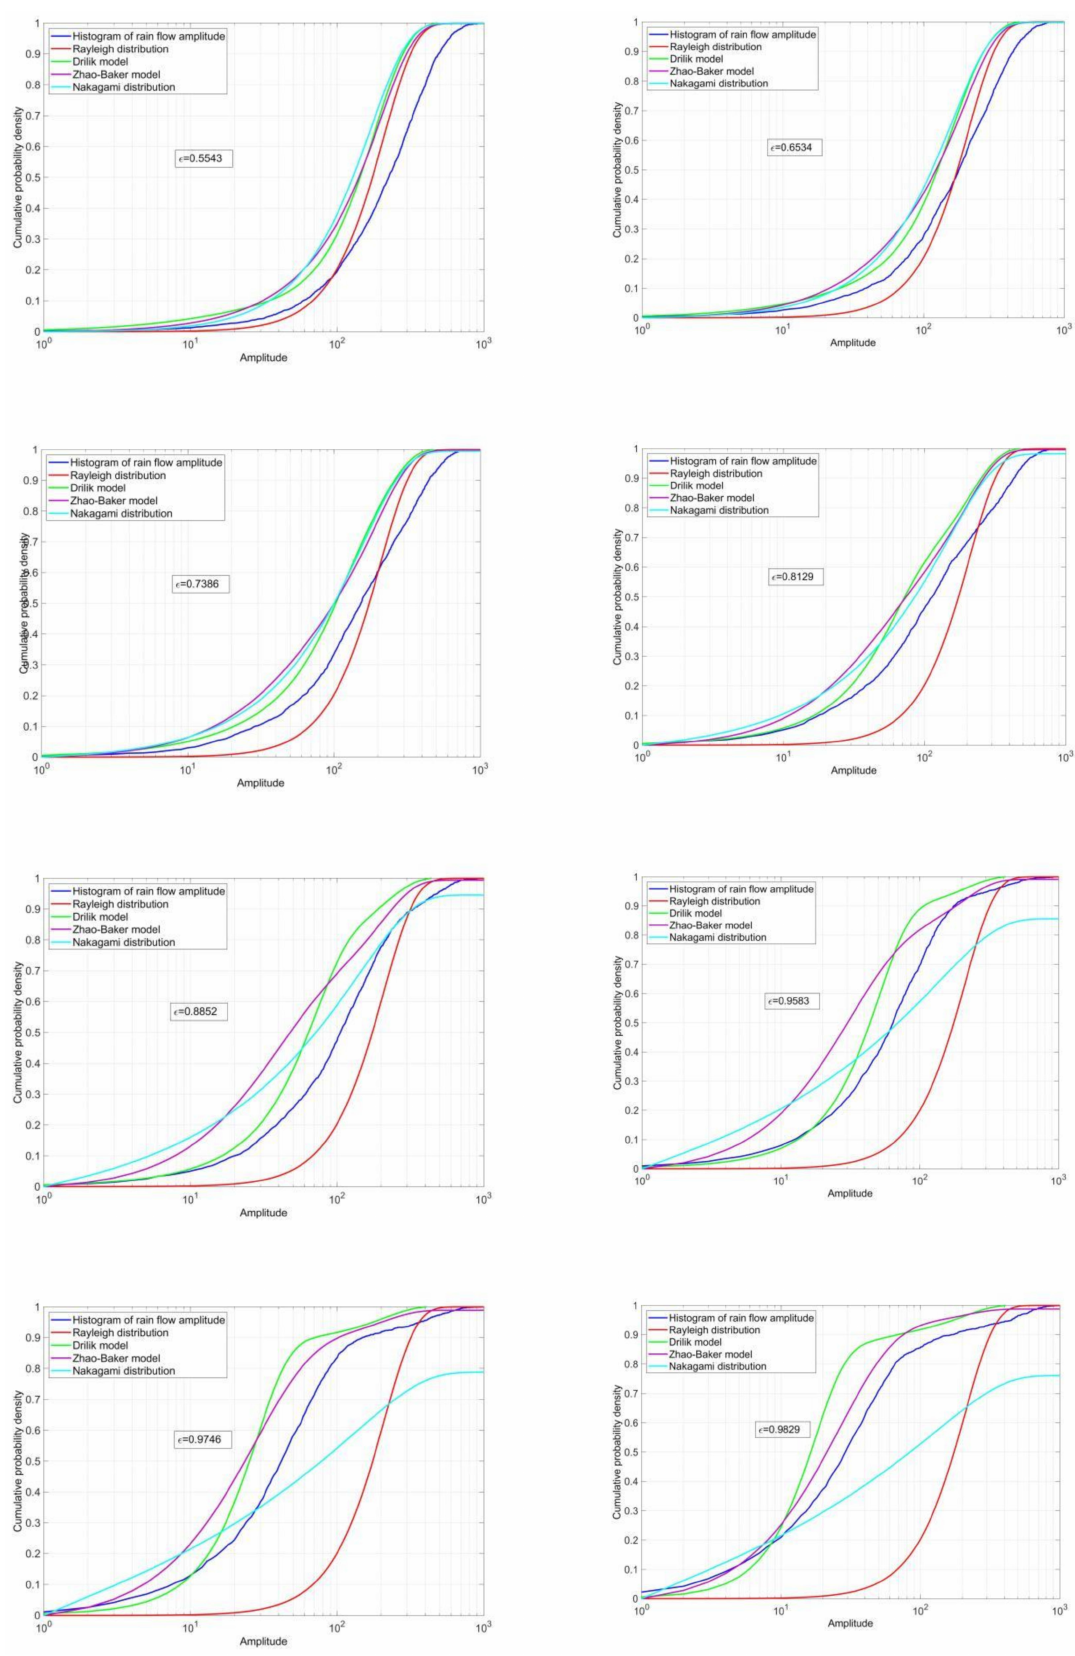
Figure A4. Rain flow amplitude CDF (bimodal